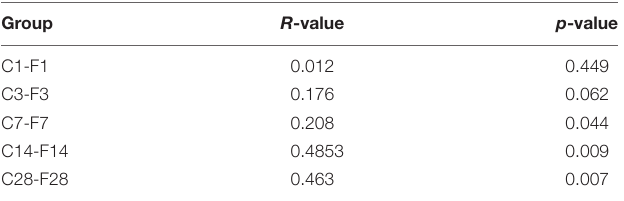
TABLE 1 | Comparison of the rank of the distance between samples by ANOSIM test. Group R -value p